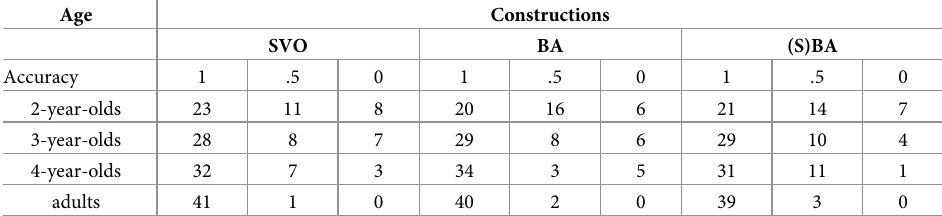
Table 3. The number of participants who responded correctly for each construction type across